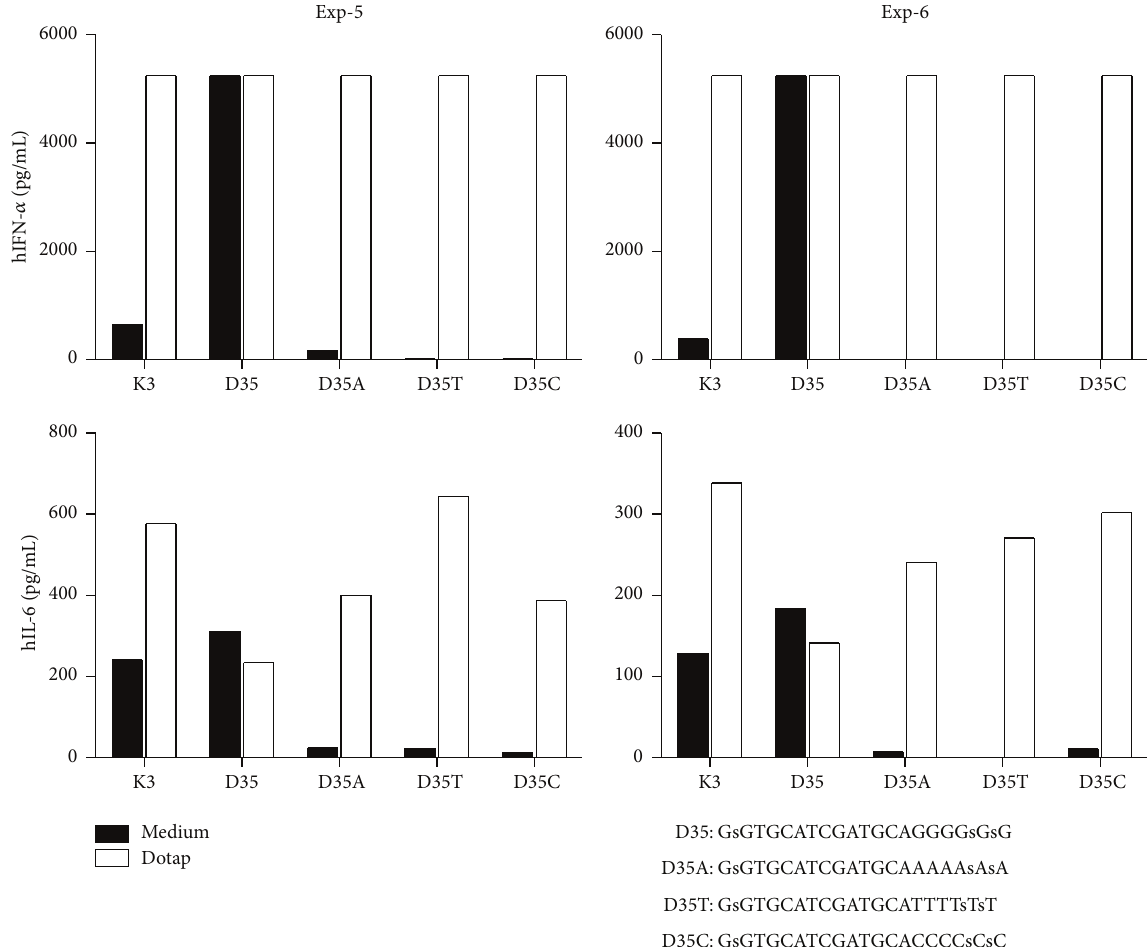
Figure 2: G-hexamer-less D35 ODNs required DOTAP for their immunostimulatory activities. Human PBMCs were stimulated with the indicated synthetic ODNs (1 𝜇 M) with or without DOTPA for 24 hours. IFN- 𝛼 and IL-6 productions in the supernatants were examined by ELISA. DOTAP revived the immunostimulatory activities of D35A, D35T, and D35C; those are A/D type ODNs which do not contain G-hexamer. These ODNs did not show any immunostimulatory activities without DOTAP. The bar graphs indicate the concentrations from a single well of each stimulation. IFN- 𝛼 production overed the ELISA measurement maximum (ca. 5000 pg/mL) with DOTAP in Exp5 and